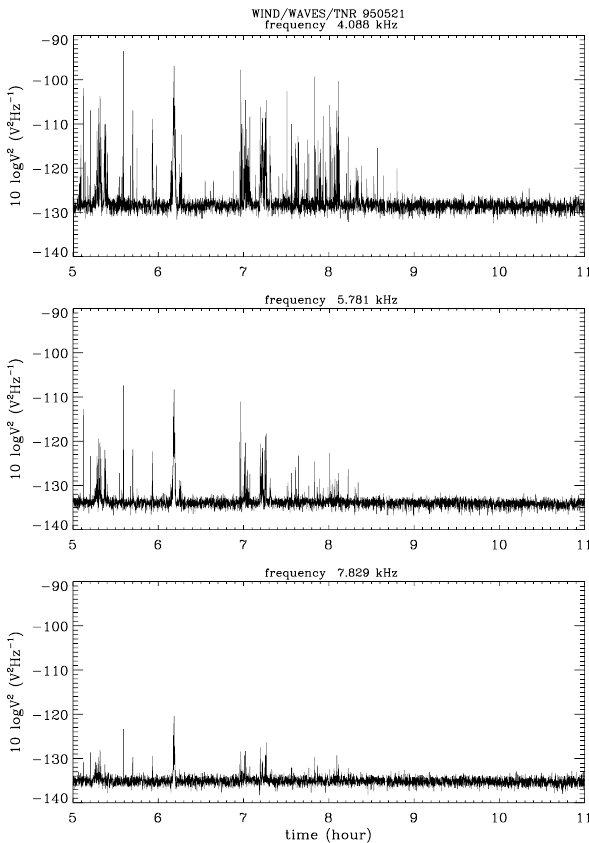
Fig. 3. Time profile of the spectral power of the electric potential at three frequencies on TNR, during six hours (sampling time: 4.5s).